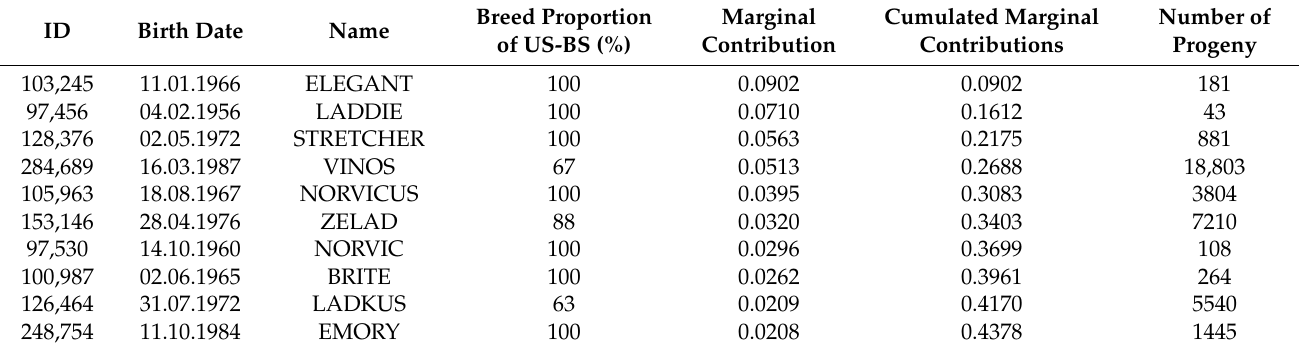
Table 2. Ancestors with the greatest marginal contributions on the reference population.